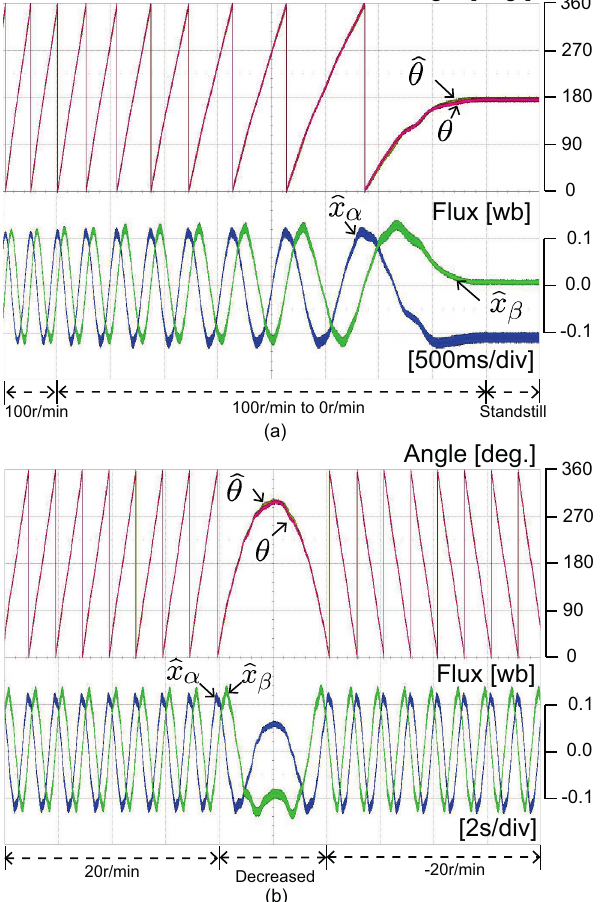
Figure 8. Speed under no load condition control performance under no-load condition: ( a ) Standstill speed control, and ( b ) reverse speed control from 20 r/min to − 20